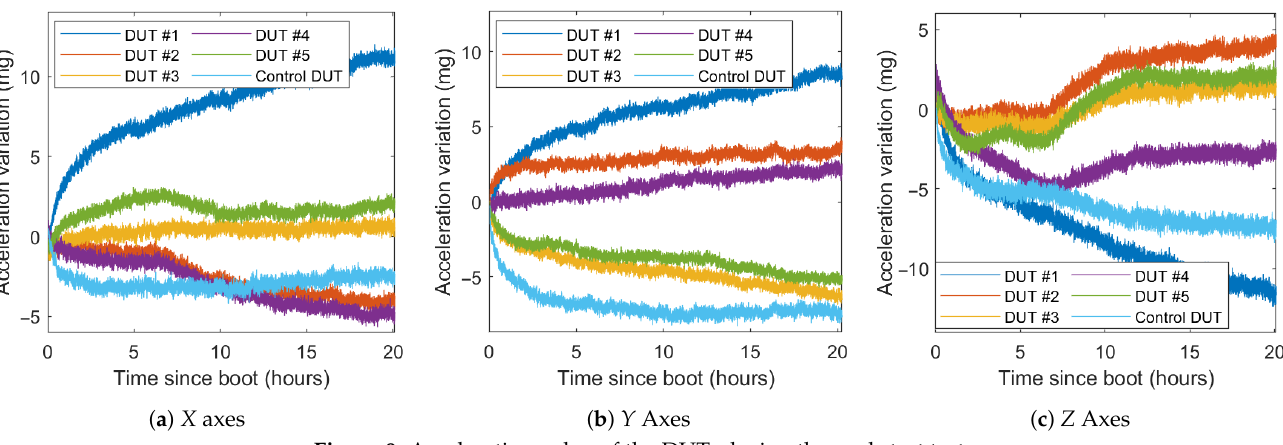
Figure 9. Acceleration value of the DUTs during the cool start